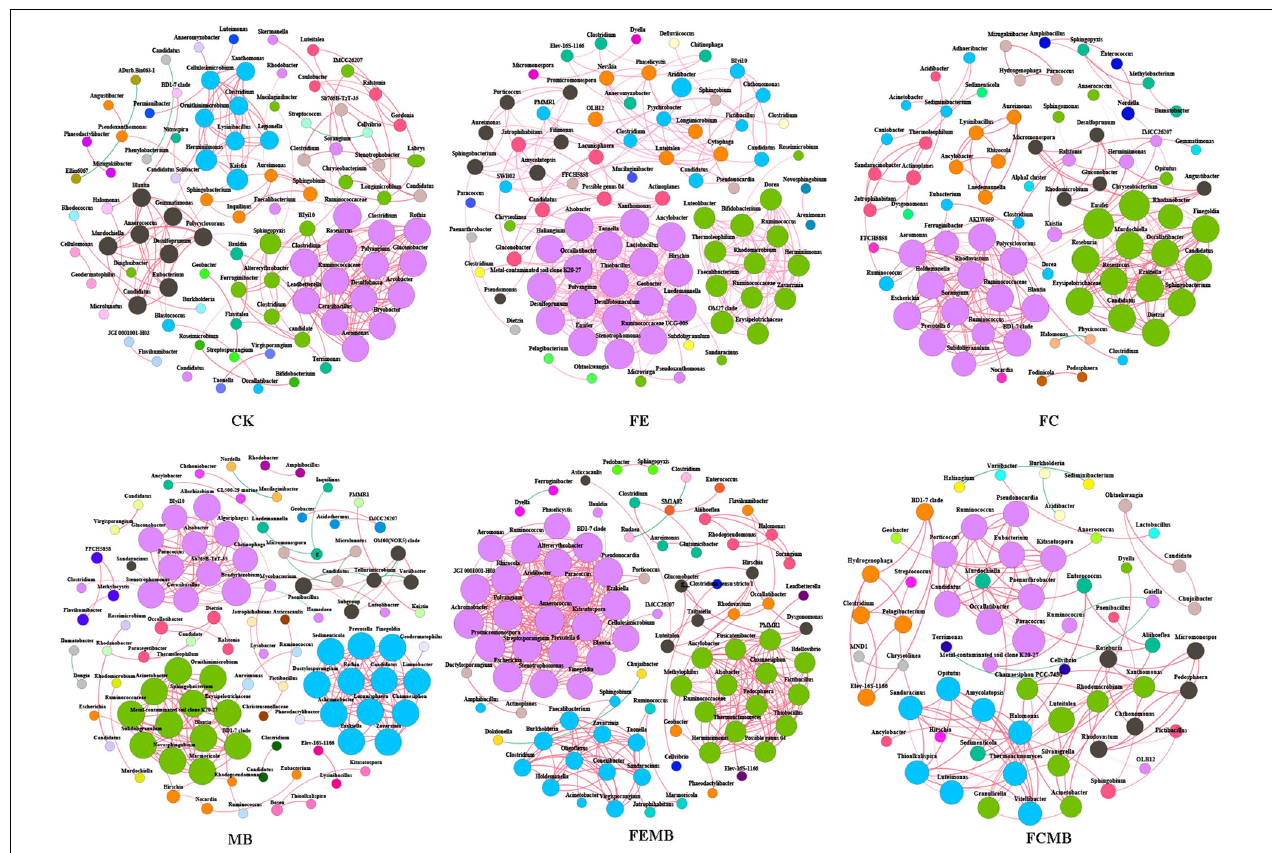
FIGURE 4 | Co-occurrence network of bacterial communities at genus level in the soil grown with H. cordata under different fertilization regimens. Different colors of nodes in networks refer to different modularity classes. The size of each node reflects the degree of connection. Red lines represent positive correlations and green lines represent negative